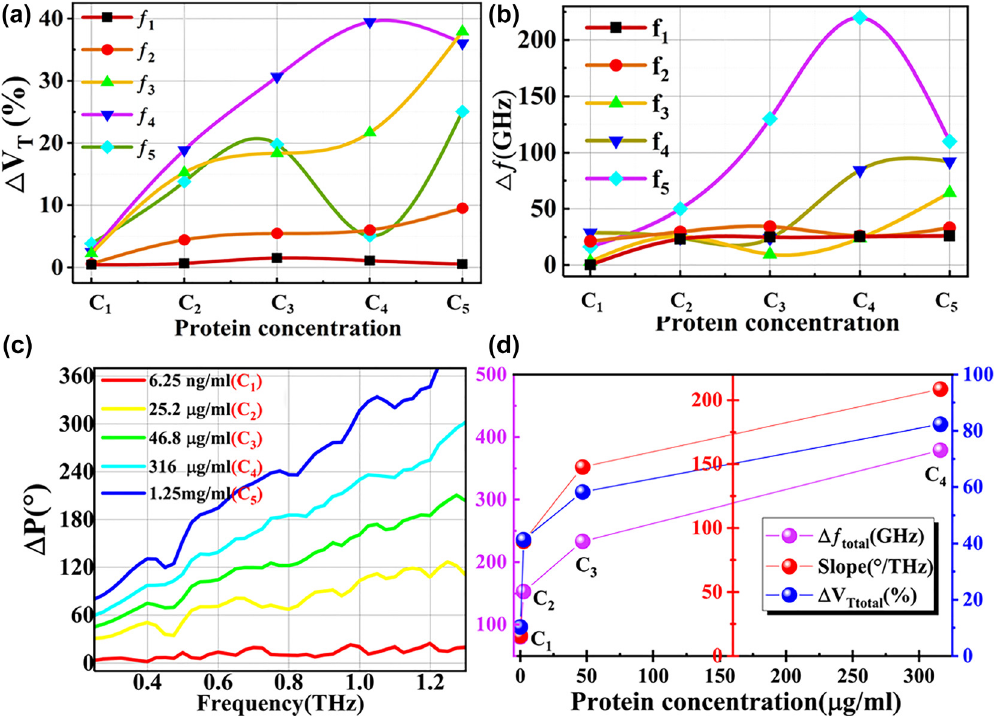
Figure 4: Quantitative analysis of multi-dimensional sensing performance. (a) and (b) The transmission value difference Δ V T (a) and frequency shift Δ ƒ (b) between the bare sensor and each CWP between C 1 and C 5 at frequencies f 1 – f 5 . (c) Phase difference Δ P between the bare sensor and each CWP tested. (d) Summary of the CWP dependence of the physical propertiesin(a) – (c).Blueaxisandmarkers:Thesumoftransmissionvaluedifference Δ V Ttotal forallfrequencypoints.Purpleaxisandmarkers: total frequency shift Δ ƒ total . Red axis and markers: fi tted slopes of the phase difference, Δ P